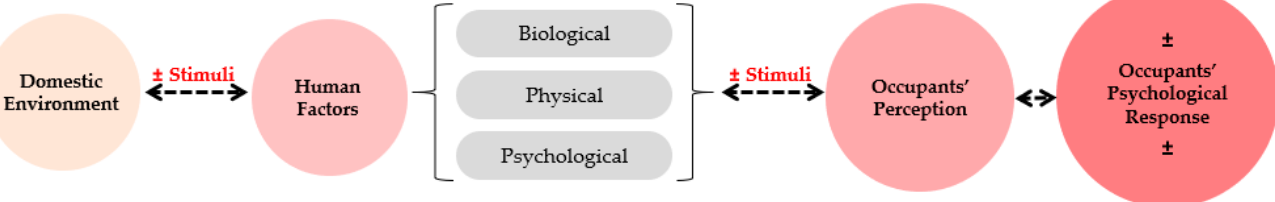
Figure 9. Domestic environment and occupants’ psychological responses. Source: [2,4,5,39,40,43,56].